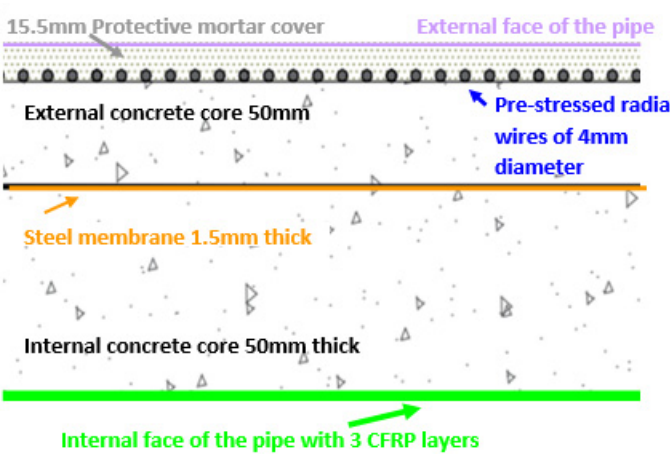
Figure 10. Cross ‐ section of the PCCP pipe with active prestressing wires and internal CFRP